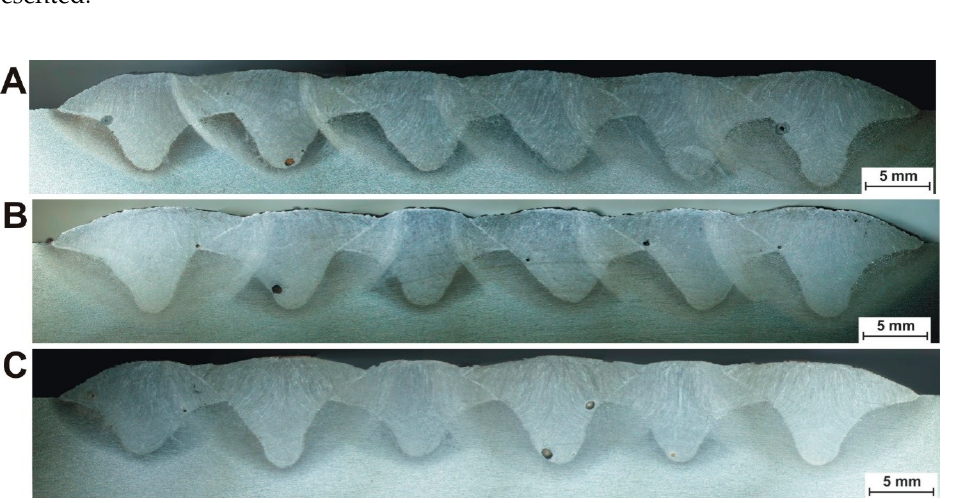
Figure 1. Photographs of plates with padded welds marked by a sequence of beads.